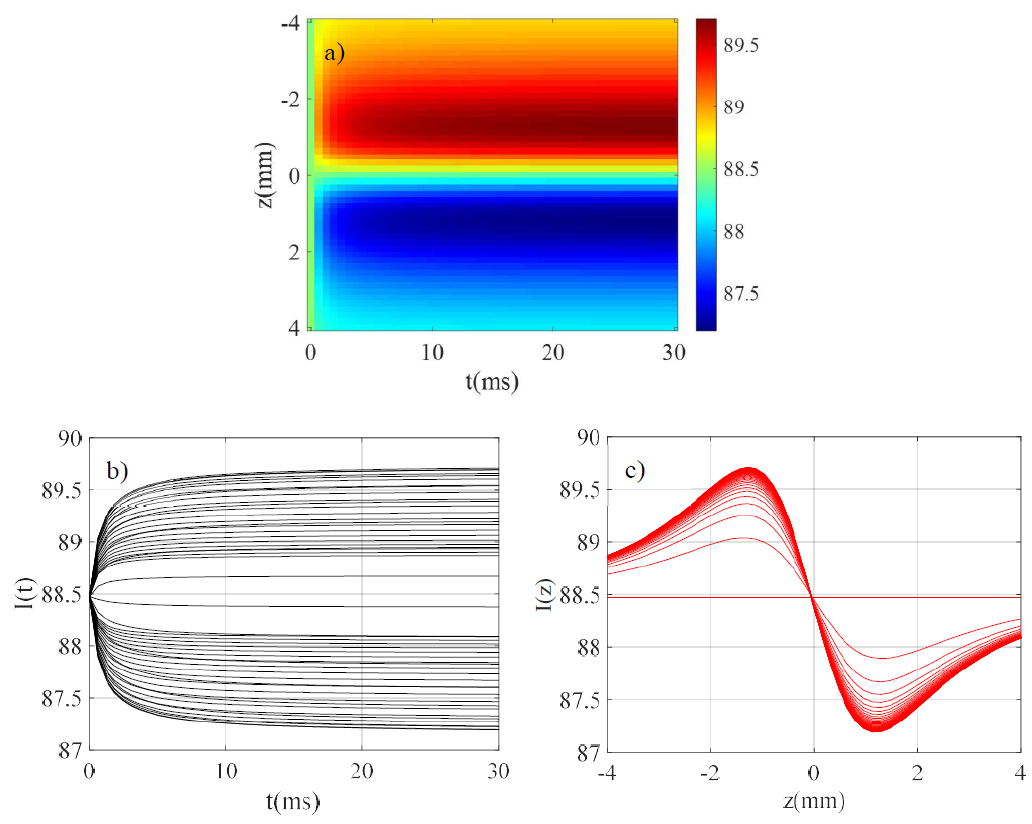
Figure 4. ( a ) Evolution of I ( z , t ) in arbitrary units; ( b ) evolution of I ( t ) considering z as a parameter; ( c ) I ( z ) considering t as a parameter.